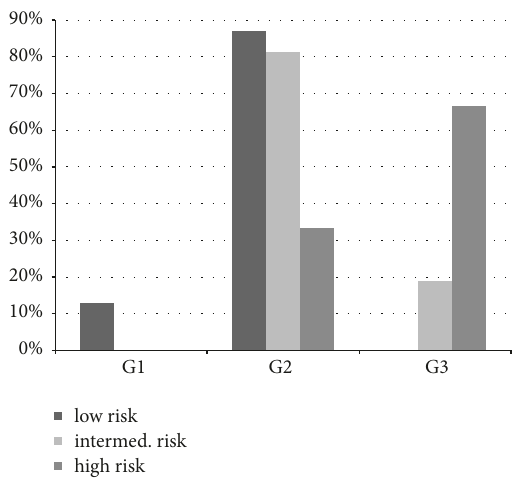
Figure 1: Histological grade of cancers within the three risk groups (well differentiated = G1, moderate = G2, and poor = G3).